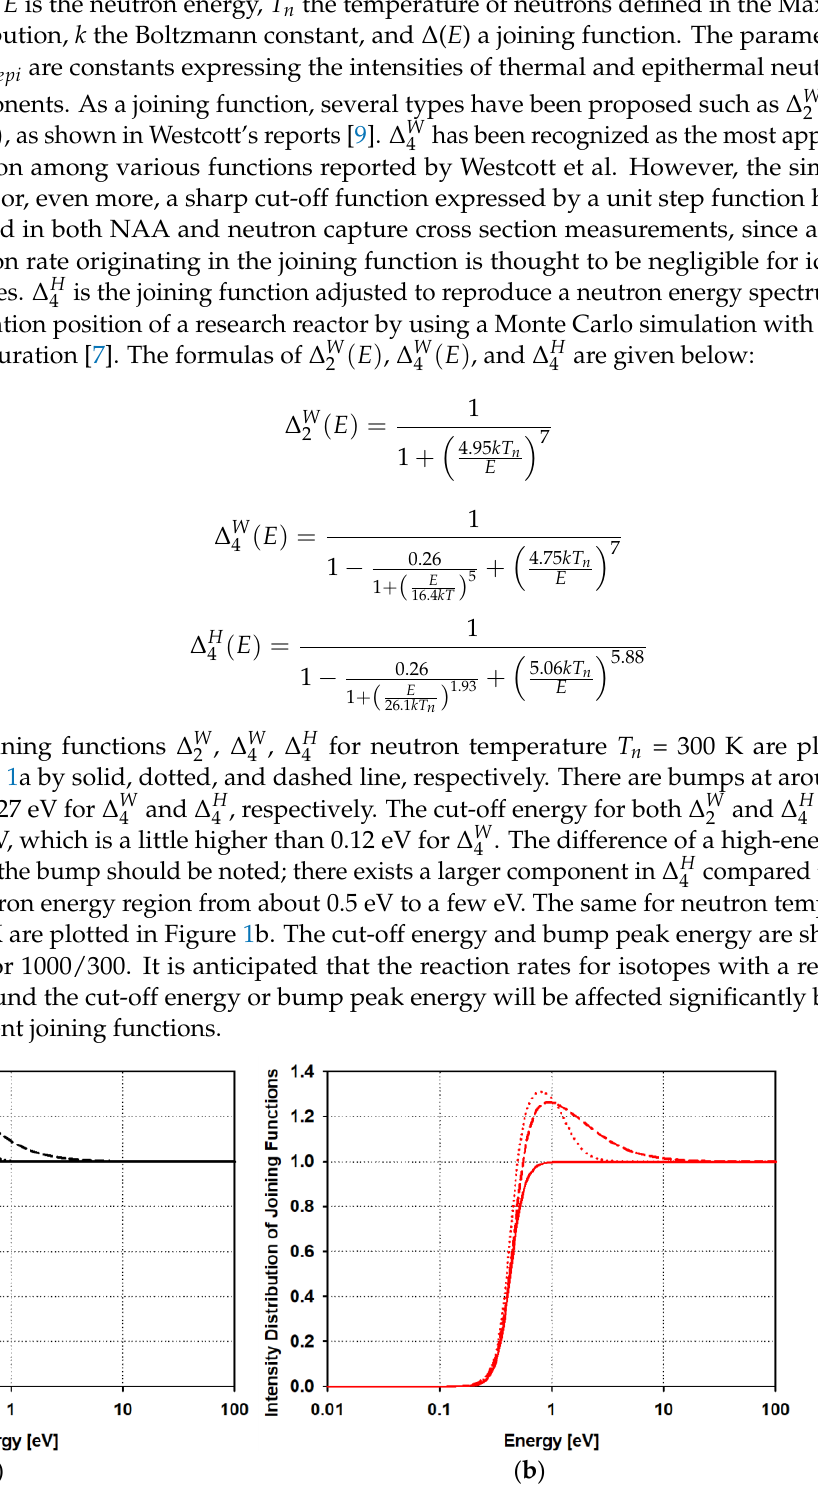
Figure 1. Joining functions ∆ W ( b ) T n = 1000